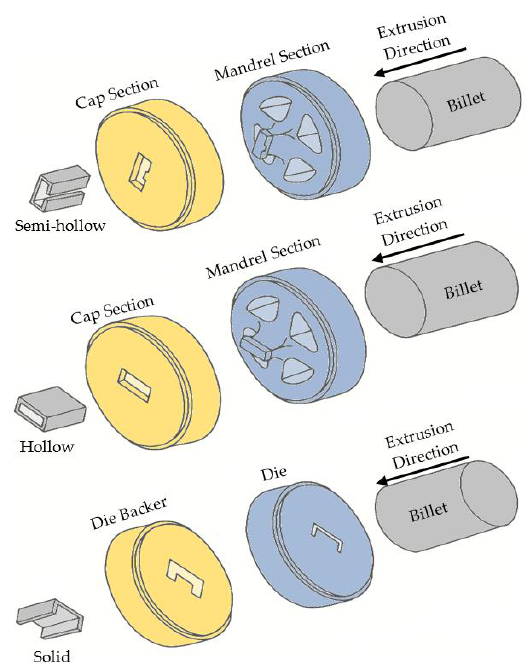
Figure 3. Schematic illustration of the extrusion setup for the semi-hollow, hollow, and solid profiles.